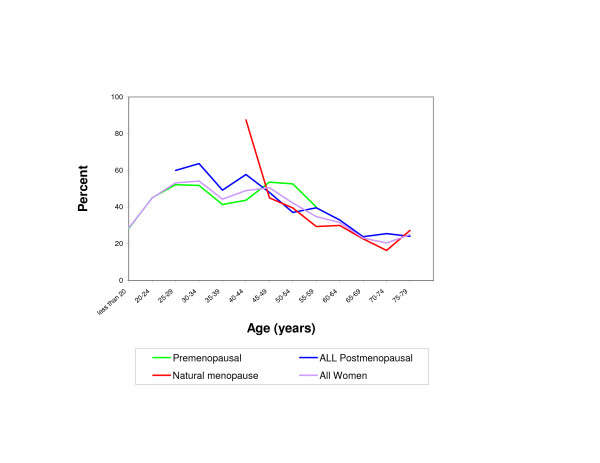
Percent of women yielding fluid by menopausal status and 5-year age groups; Sartorius Nipple Aspirate Cohort, 1970–1990. * natural menopause is defined as menopause that was not induced by chemotherapy, radiation or ovarian ablation.